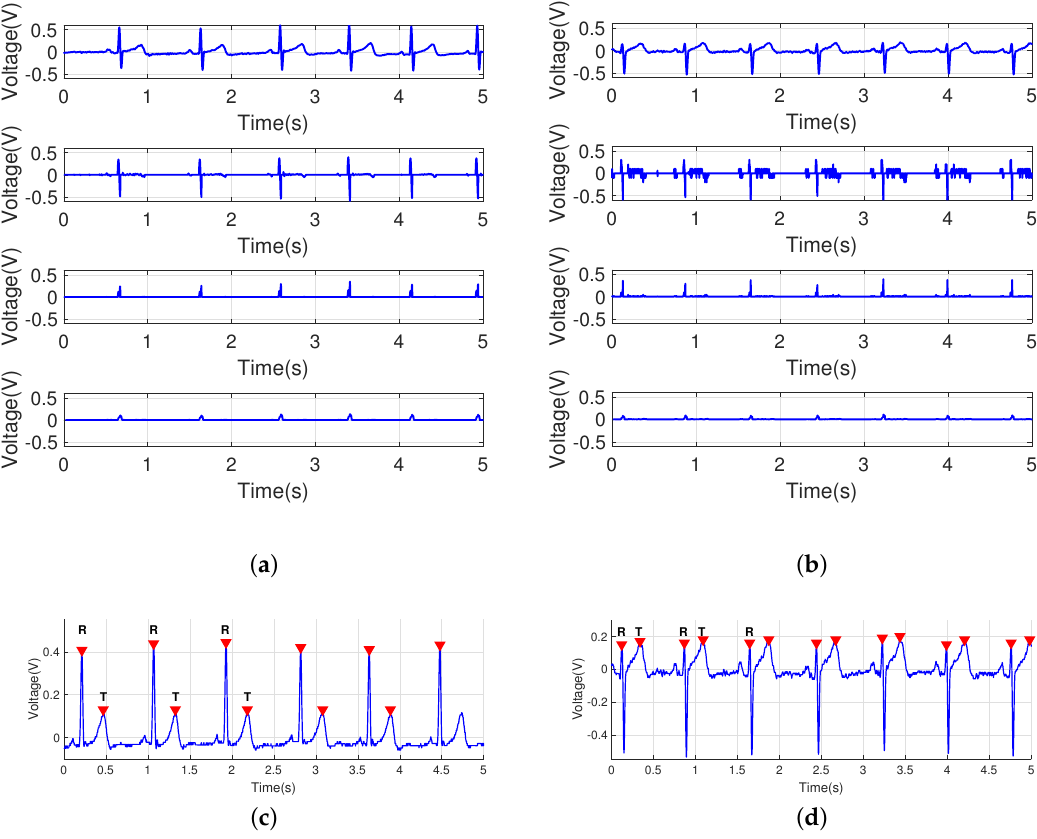
Figure 5. Extracting the peak points for two different ECG signals: ( a , b ) results of the sequential process for extracting the peak points; signal after band-pass filtering, differentiated signal, squared signal, and signal passing through the moving average filter; ( c ) detected peak points (R and T points) for the ECG signal in Figure 4 (top); ( d ) detected peak points (R and T points) for the ECG signal in Figure 4 (bottom); another pass of scanning is needed to determine the T points after a pair of R points are